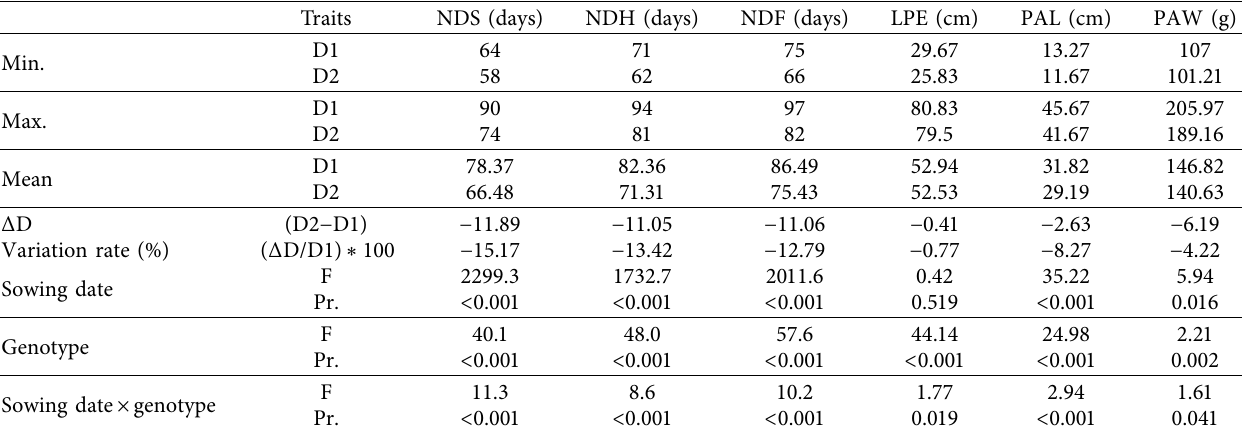
Table 3: Results of the analysis of variance of agronomic traits.